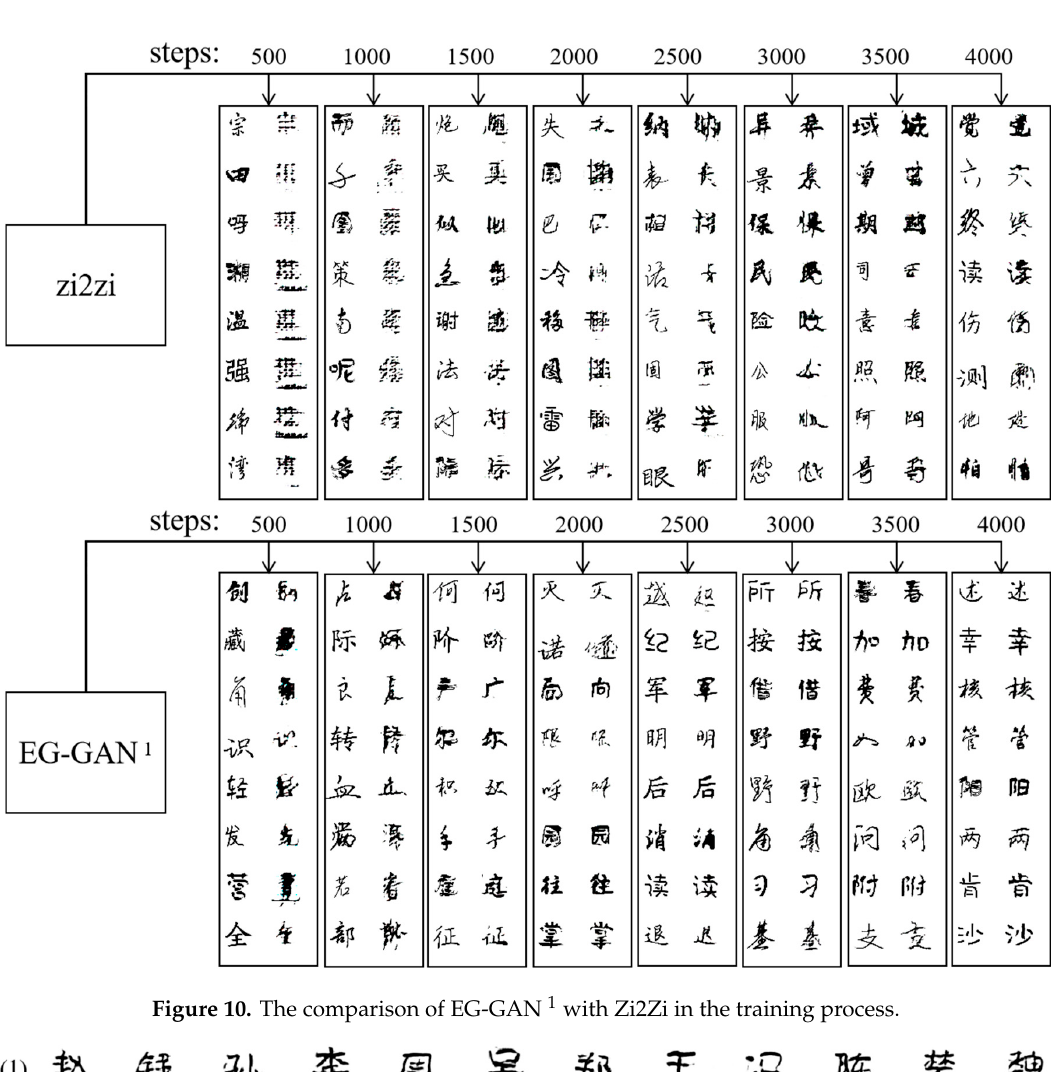
Figure 10. The comparison of EG-GAN 1 with Zi2Zi in the training process.